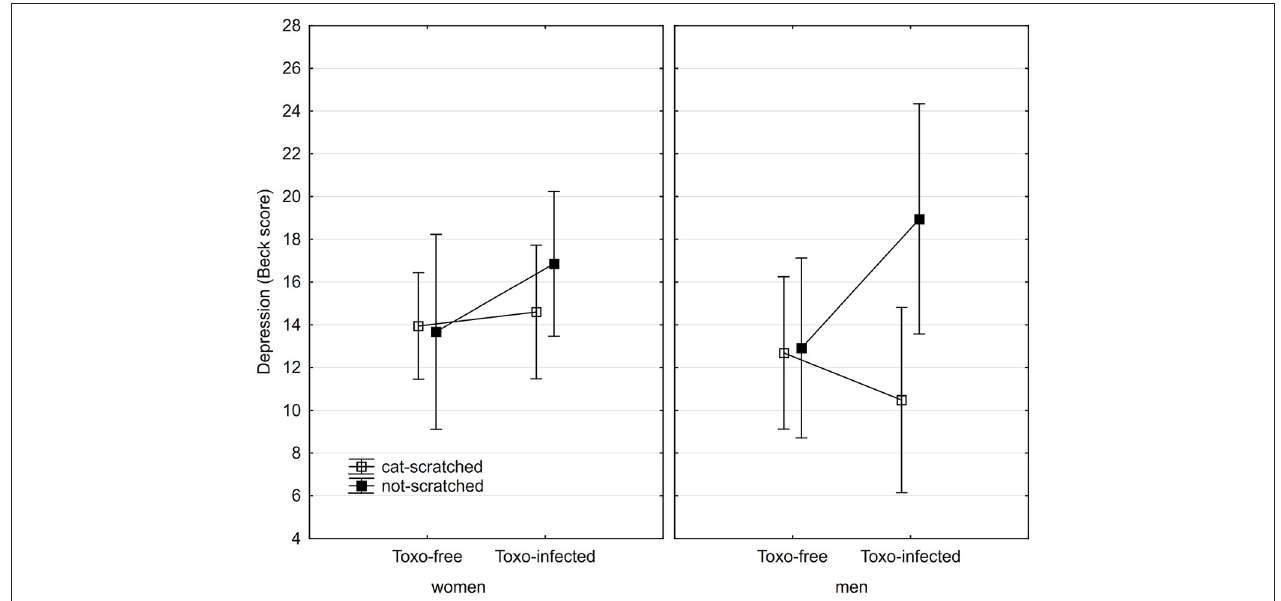
FIGURE 4 | Association of cat scratching and Toxoplasma seropositivity with BDI-II depression score. Squares show depression computed for covariates at their means and spreads 95% confidence